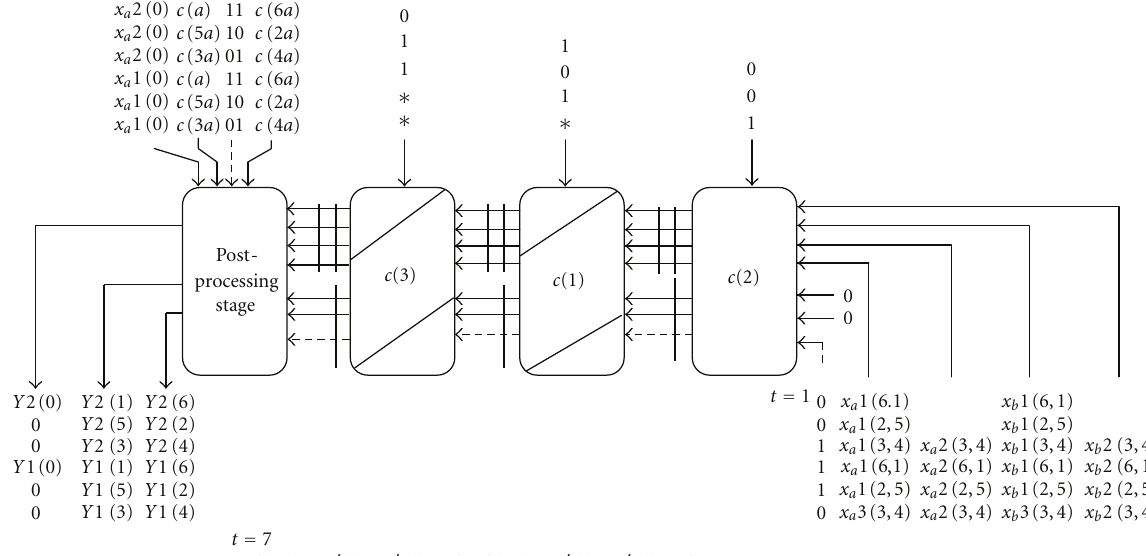
Figure 1: Systolic array architecture for DCT of length N = 7.